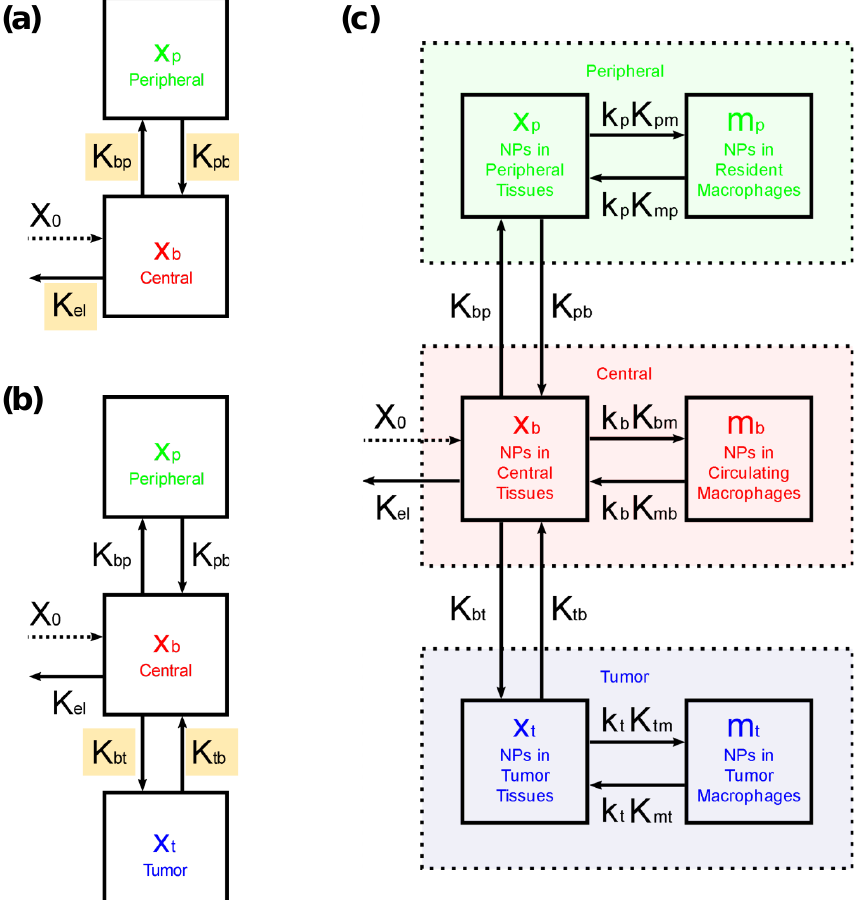
Figure 5. Pharmacokinetic (PK) compartment models. ( a ) Typical two-compartment model used to describe the PK of a small molecule drug. ( b ) Three-compartment model used within the context